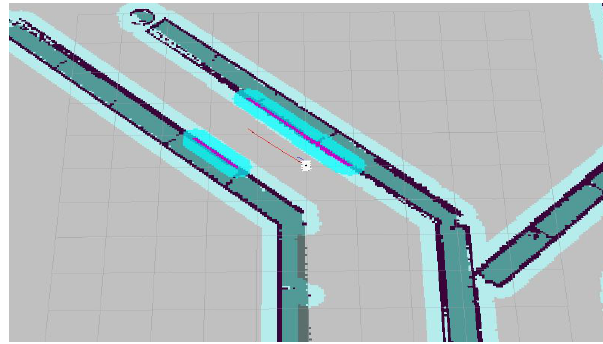
Figure 9. Navigation